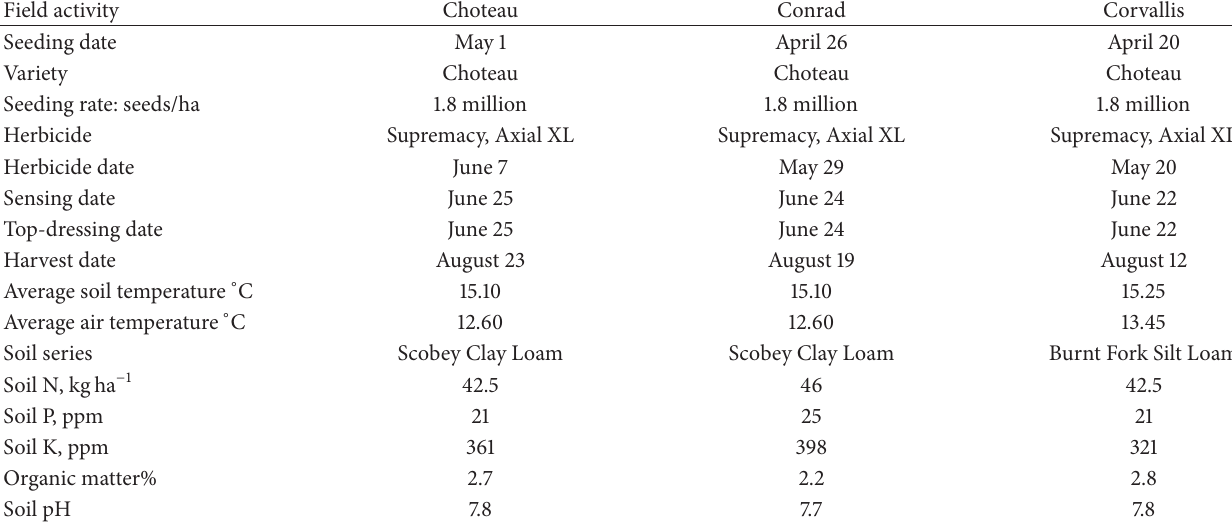
Table 3: Field activities and growing conditions, Conrad, Choteau, and Corvallis,